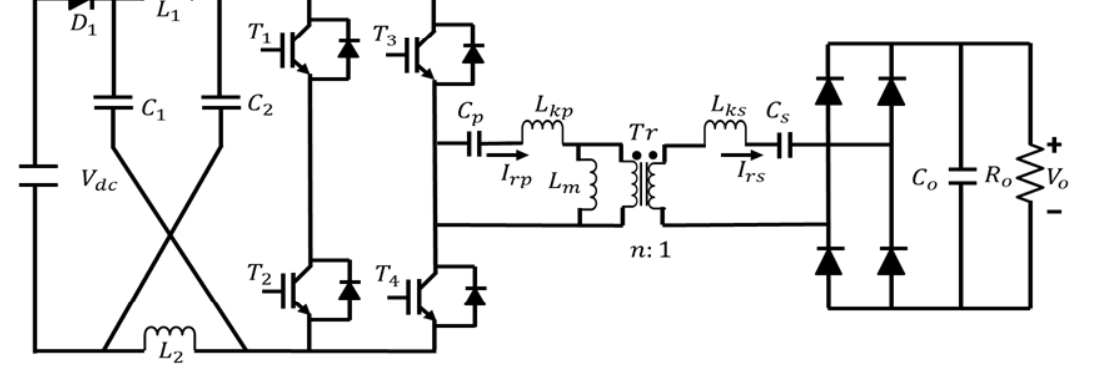
Figure 13. Z-source resonant converter topology.